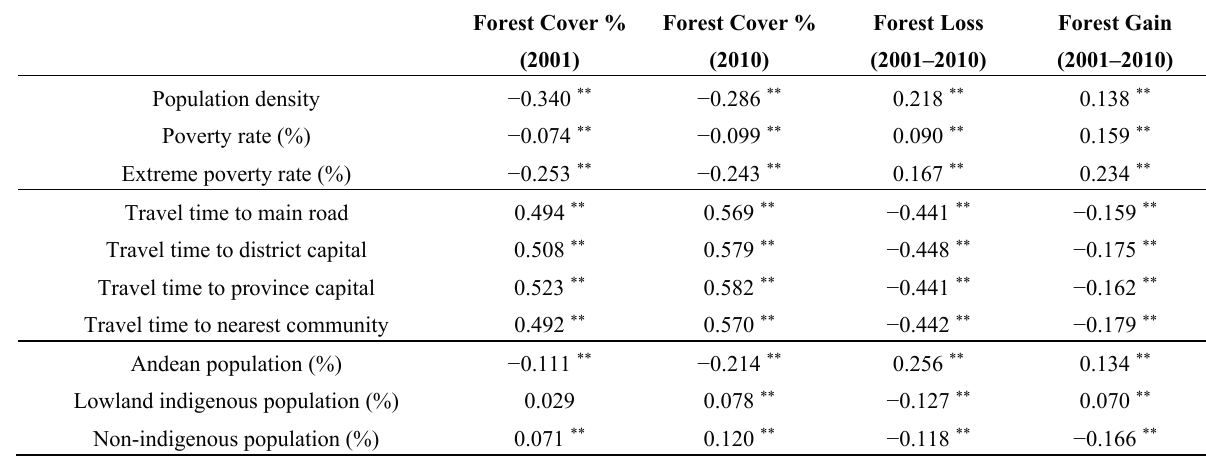
Table 7. Pearson correlations between forest cover change and socio-economic variables in the Santa Cruz agro industrial